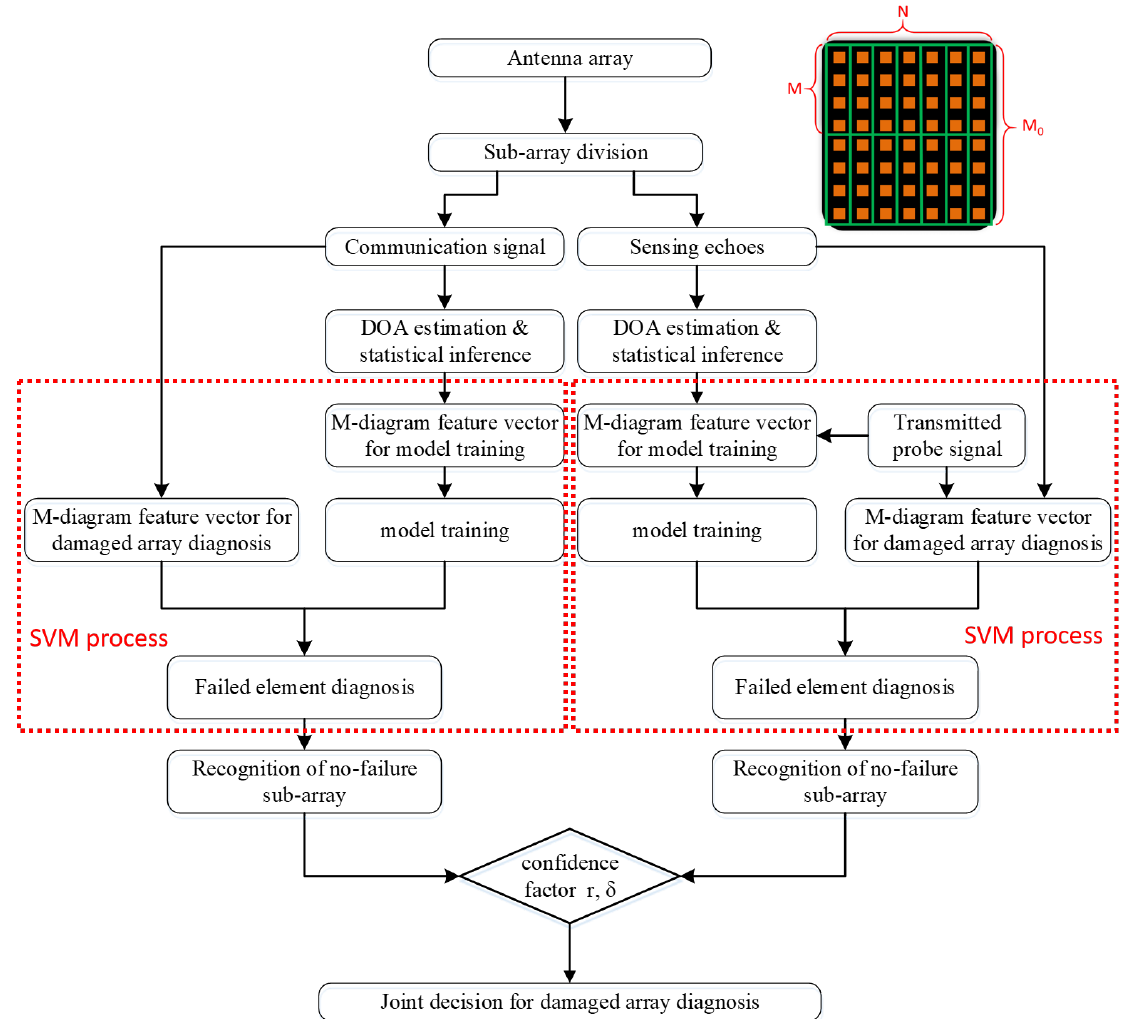
Figure 2. Diagram of the joint diagnosis algorithm based on radar-communication system and the division of